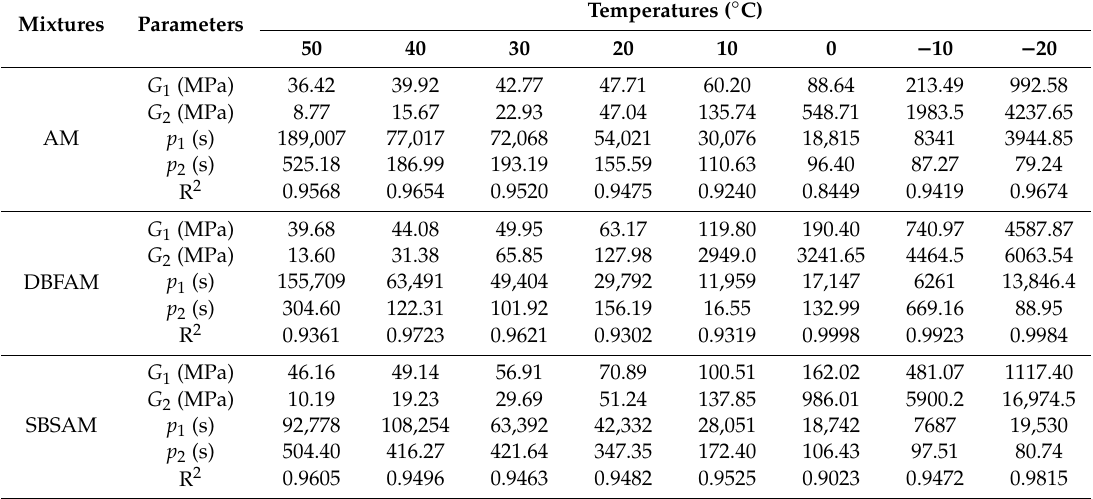
Table 8. The fitting parameters of the relaxation properties based on the Burgers model.